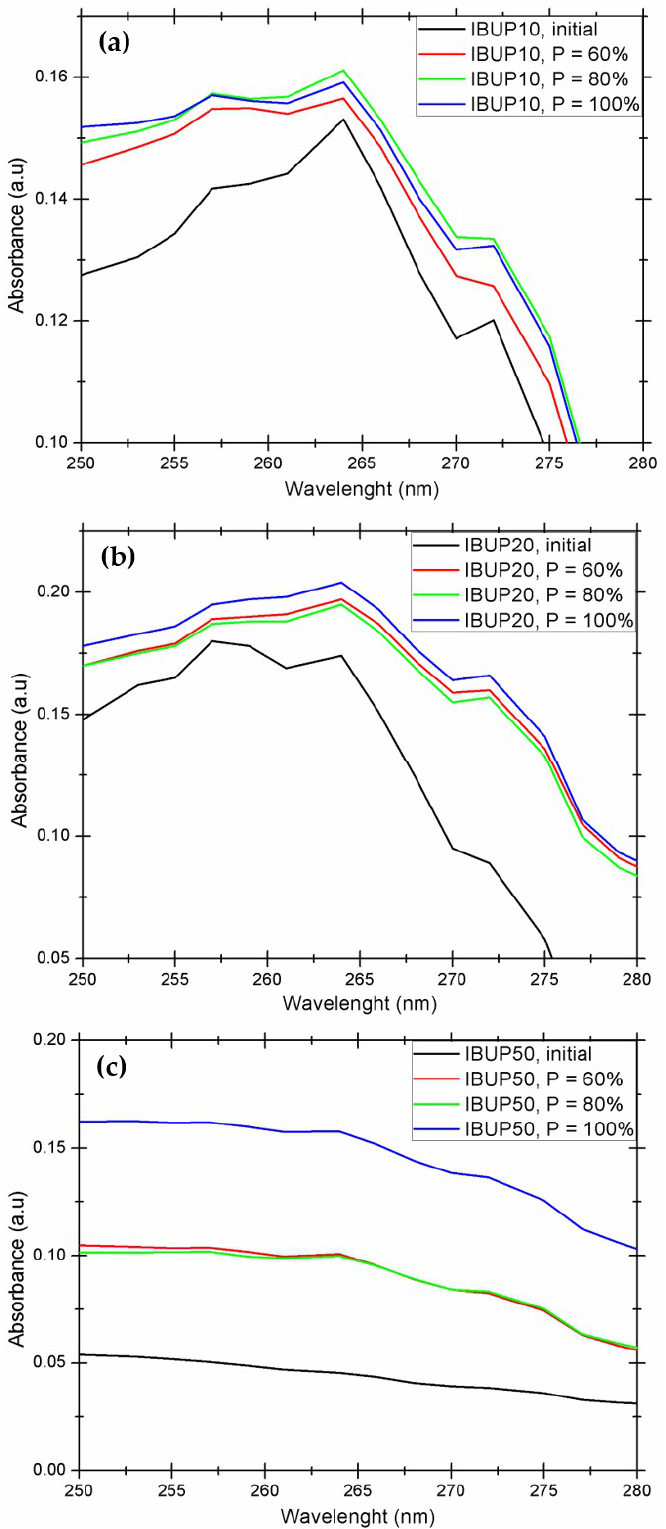
Figure 7. UV-Vis spectra of PLGA-Fe 3 O 4 -IBUP systems resulted after hyperthermia tests. ( a ) IBUP10; ( b ) IBUP20; ( c ) ( b ) IBUP20; ( c ) IBUP50.